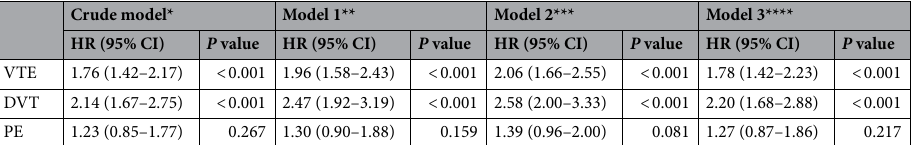
Table 3. Risk of venous thromboembolic events in patients with IBD. Reference: non-IBD controls. IBD inflammatory bowel disease; VTE venous thromboembolism; DVT deep vein thrombosis; PE pulmonary embolism; HR hazard ratio; CI confidence interval. *Matched on age and sex. **Multivariable-adjusted model 1: adjustment for provoking factors (recent surgery, fracture, systemic corticosteroids, and pregnancy within 90 days of event). ***Multivariable-adjusted model 2: Model 1 plus adjustment for co-morbidities (hypertension, diabetes, cardiovascular disease, cerebrovascular disease, heart failure, atrial fibrillation, and chronic kidney disease). ****Multivariable-adjusted model 3: Model 2 plus adjustment for history of anticoagulation